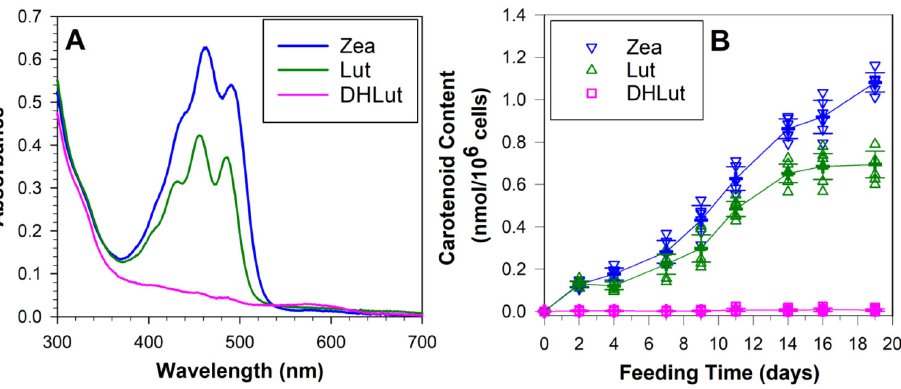
Figure 5. ARPE-19 cells accumulate lutein and zeaxanthin but not dehydrolutein . ( A ) Representa- tive absorption spectra of extracts from ARPE-19 cells supplemented for 19 days with cell culture medium containing 10% FCS enriched with 2 µM lutein (Lut), dehydrolutein (DHLut), or zeaxan- thin (Zea). ( B ) Concentrations of lutein, zeaxanthin, and dehydrolutein in ARPE-19 cells fed for in- dicated number of days with culture medium enriched with 2-µM carotenoids.